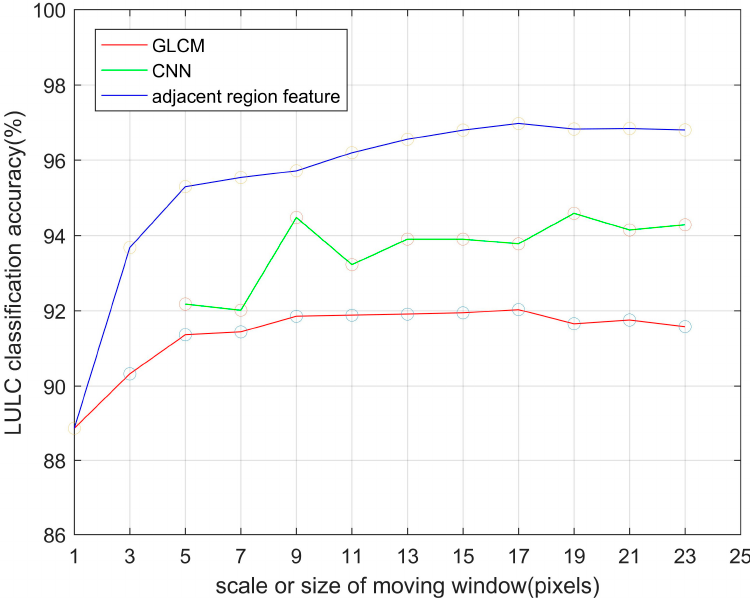
Figure 8. Performances of grey level occurrence matrix (GLCM), CNN, and adjacent region features with feature set configurations that achieved the highest overall accuracies.